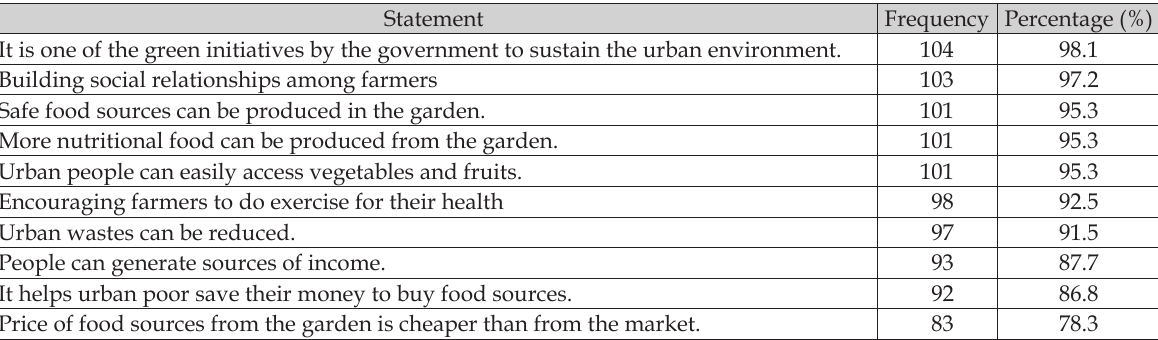
Table 2. Perspective of practitioners on benefits of urban